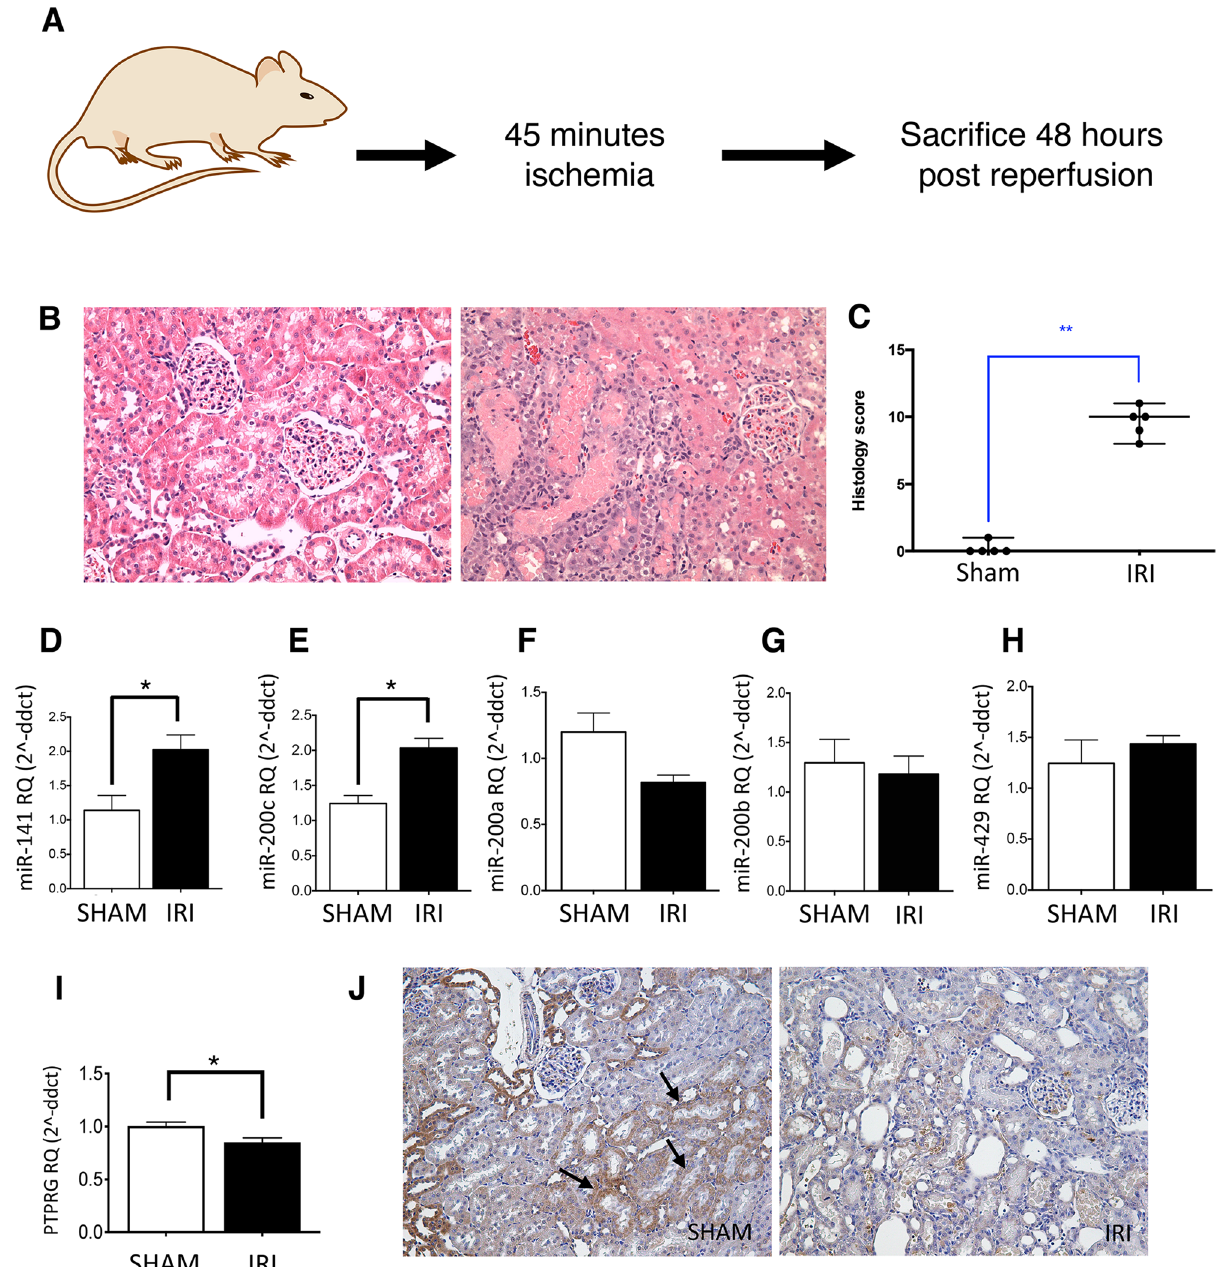
Figure 7. MiR-200 family expression in a rat unilateral ischaemic reperfusion injury (IRI) model of AKI. ( A ) A diagram depicting our unilateral IRI model in Lewis male rats and ( B , C ) histological evidence of tubular damage. ( D - H ) RT-qPCR analysis of the miR-200 family expression in rat kidneys from animals in sham and IRI experimental groups. Detection of miR-141 and miR-200c was upregulated in the unilateral IRI model (twofold, D , E ), while miR-200a, miR-200b and miR-429 showed no significant changes between sham and unilateral IRI groups ( F – H ). RT-qPCR analysis of PTPRG expression in whole kidney showed a significant injury-specific decrease in PTPRG expression ( I ). Histological analysis demonstrated clear kidney tubular PTPRG expression in sham tissue sections, including expression in PTECs (e.g. see arrows), which was not present in IRI tissue sections ( J ). Statistical analysis for IRI compared to controls was carried out by unpaired T-test (n = 4). Data were normalised to endogenous control miR-191 and are presented as mean ± SEM; *p < 0.05, **p <